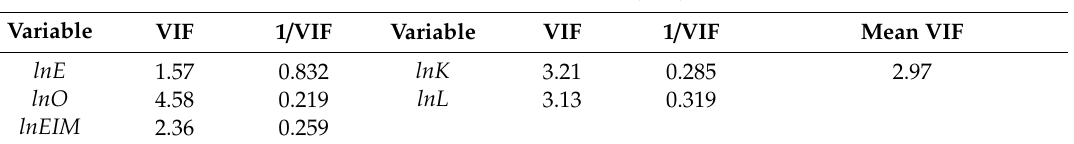
Panel B: The Variance Inflation Factor (VIF) Test